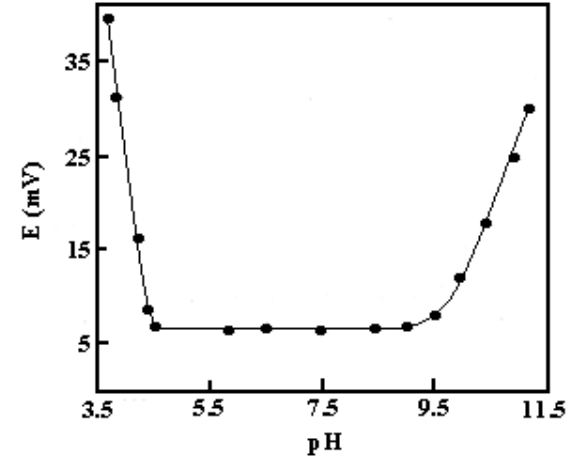
Figure 3. Effect of pH on the strontium test solution.